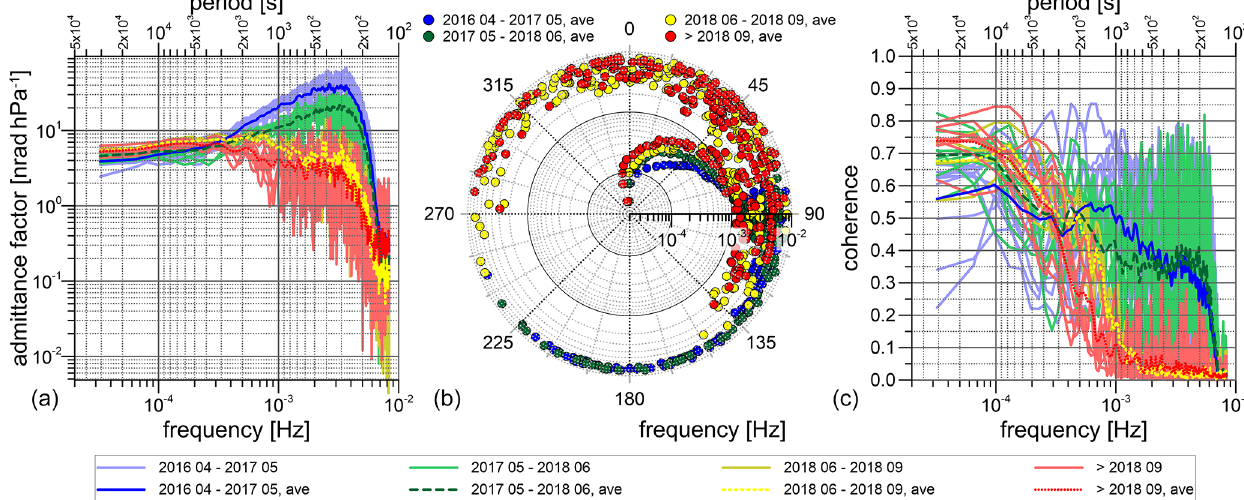
Figure A1. Air pressure admittance function of the N–S tilt sensor (LTS) derived from different observation periods covering a period of a few days to less than 3 weeks each. Circles and lines with intense colours show the admittance (a) , phase (b) and coherence (c) , respectively, averaged over the time series within four intervals (the beginning to May 2017; May 2017–June 2018 (first LTS repair); June–September 2018 (second LTS repair); September 2018 to the end).